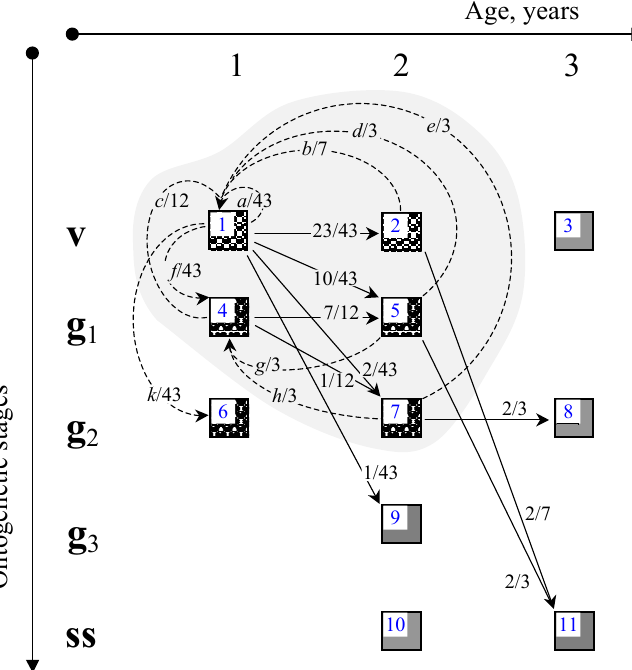
Figure 2. LCG for Calamagrostis epigeios according to the excavation data of a 3-year-old colony in 2015: v denotes the stage of adult vegetative plants; g i ( i = 1, 2, 3), generative plans with i generative shoots; ss and s , subsenile and senile stages, respectively. Solid arrows indicate the ontogenetic transitions that have occurred for 1 year: numbers at the arrows indicate proportions of the tufts outgoing from an initial status in 2014 and reaching the ingoing status by 2015; the number inside the vertex is the ordinal number the corresponding component has in the vector of population structure; gray background highlights the reproductive core of the LCG (Figure 4 I in